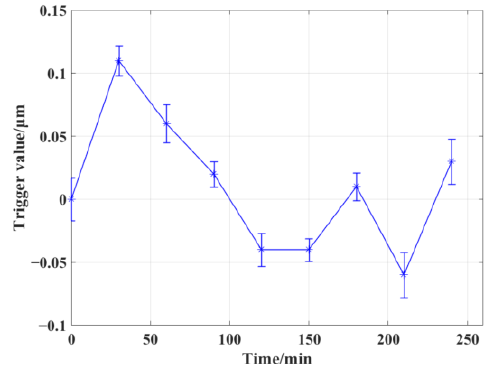
Figure 9. Long-term repeatability testing of the OMM.